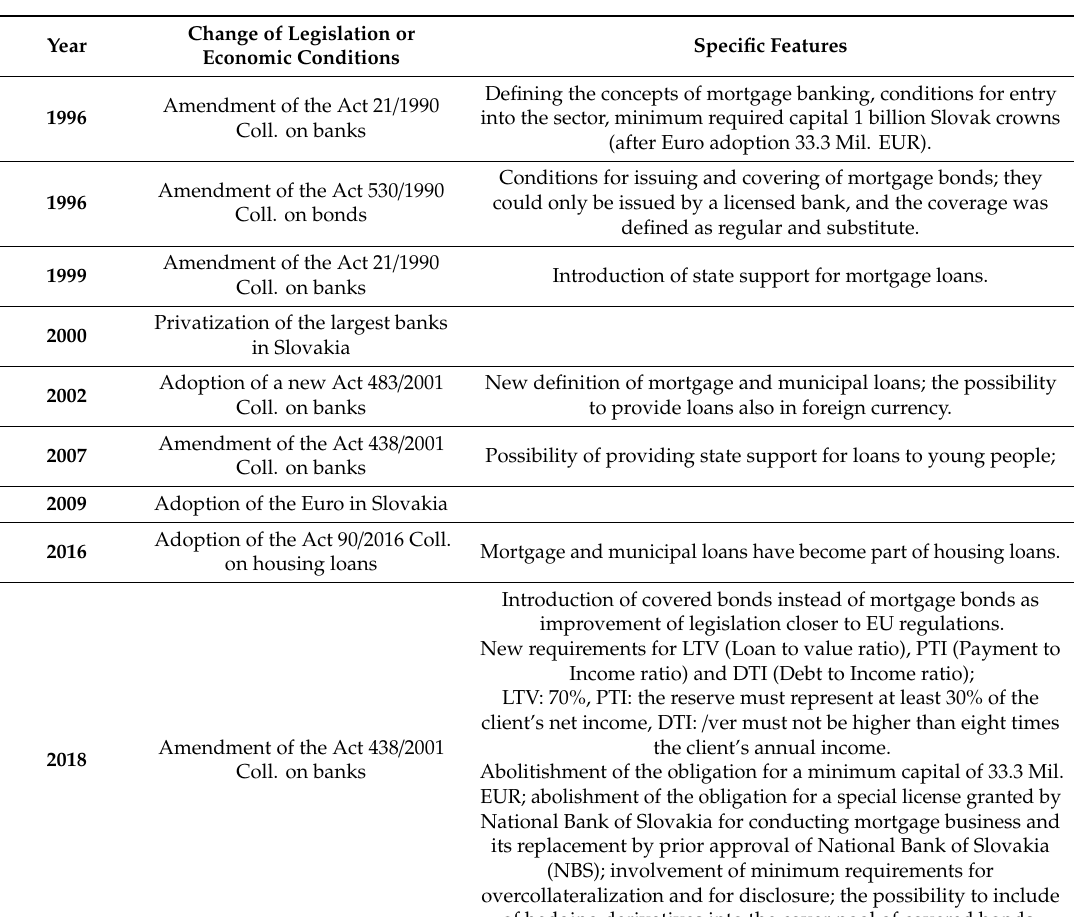
Table 4. An overview of the main changes in mortgage banking in